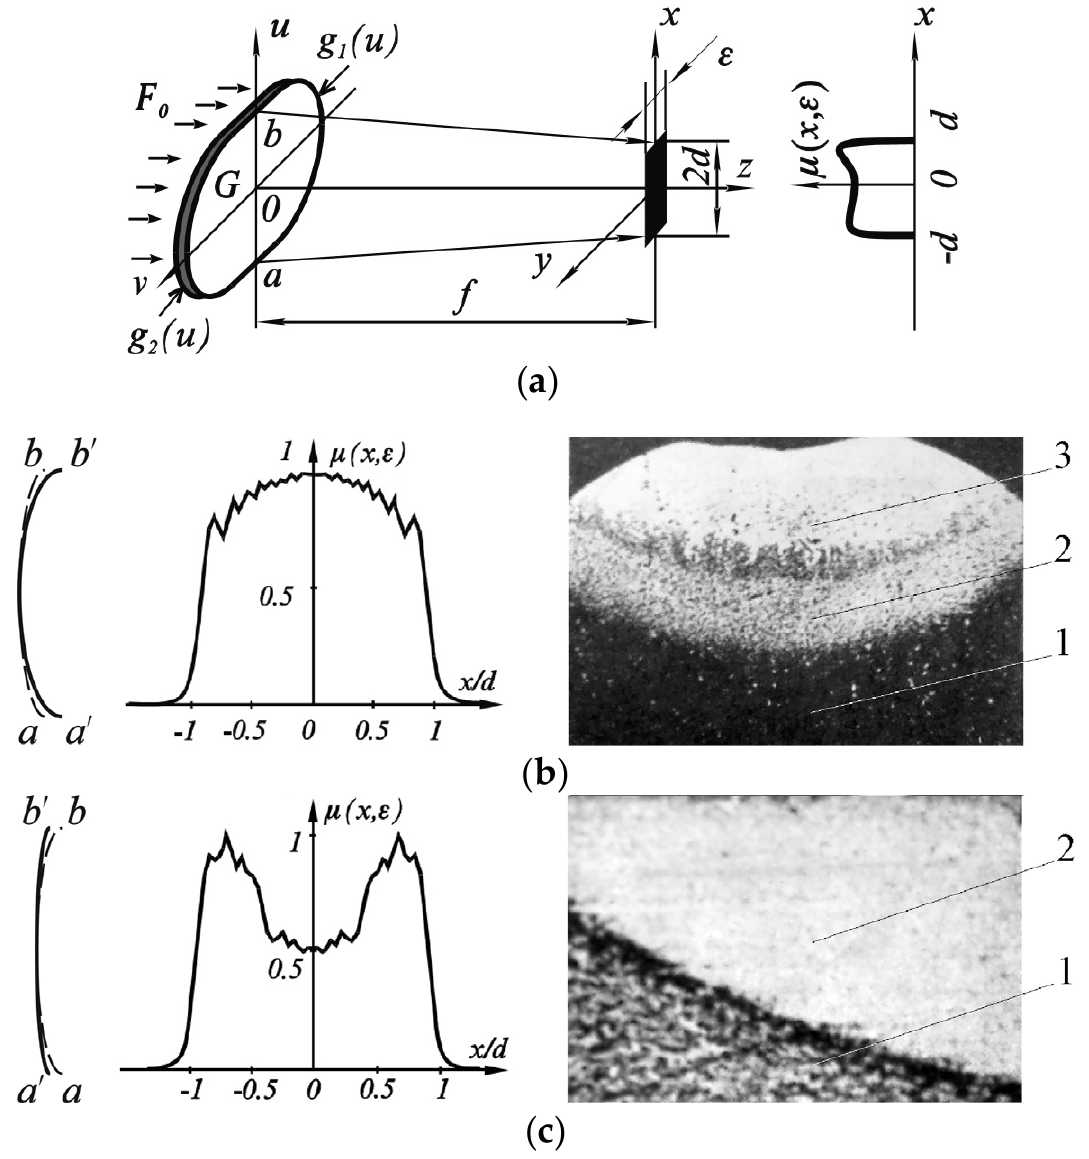
Figure 1. Geometry of the focusing of a laser beam ( a ) [17], schematic images of deviations a ′ b ′ from the calculated surface ab as well as the function µ (x , ε) that characterize the distribution of energy [17] and resulting defects. Defects in the cross-sections of the heat-affected zones of steels during laser processing: an uneven processing depth along the width of the heat-affected zone of carbon tool steel ( b ) and local melts when processing alloy tool steel ( c ): 1—initial structure; 2—area of hardening without melting; 3—melting area [18].